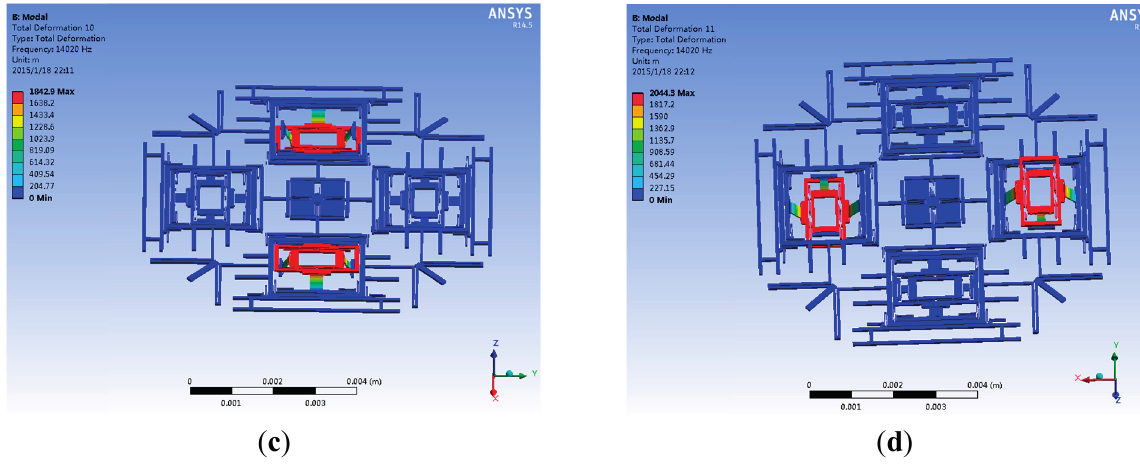
Figure 9. The modal analysis results of the tri-axis gyroscope: ( a ) The drive mode; ( b ) The yaw mode; ( c ) The pitch mode; ( d ) The roll